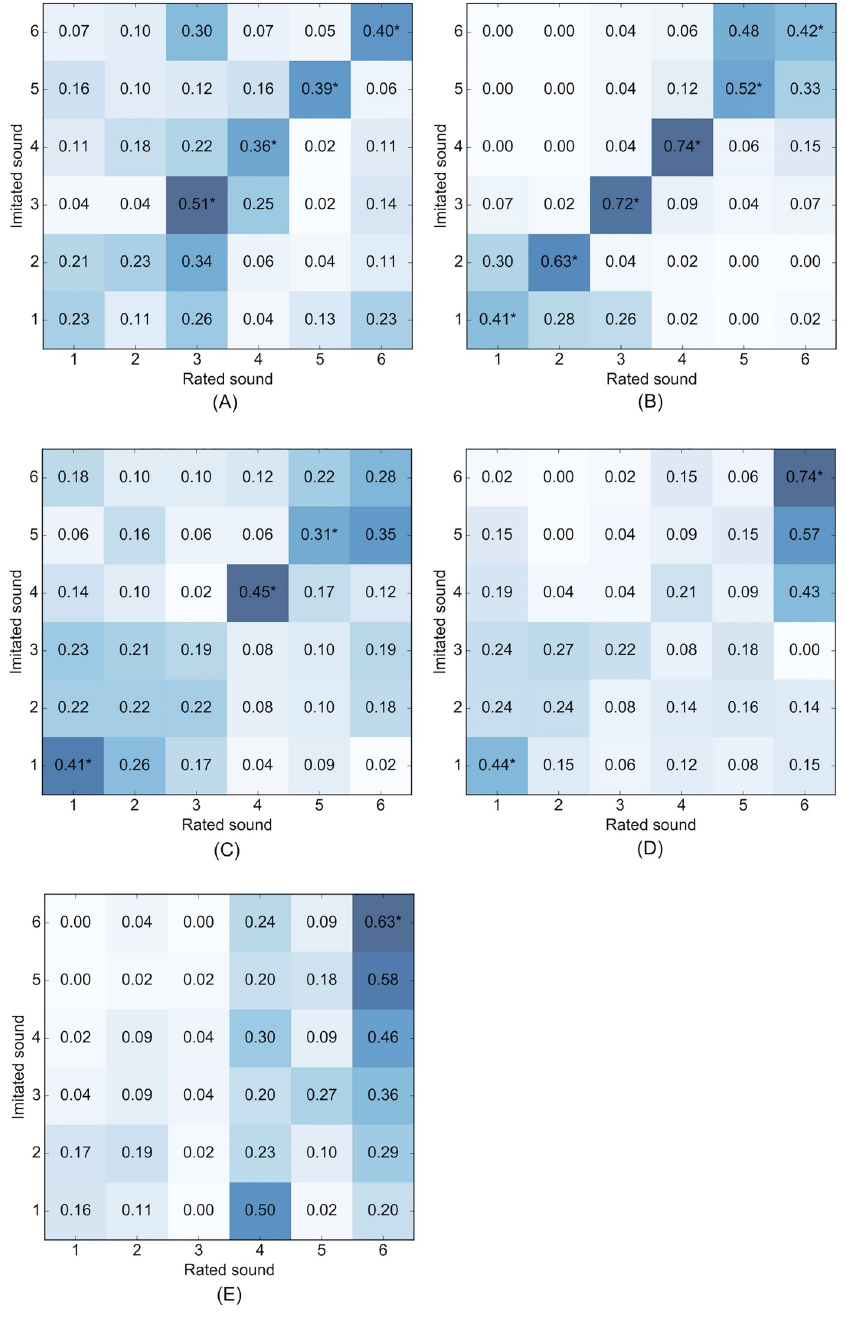
Fig 2. Contingency tables of the highest rated sound for each imitated (i.e. target) sound, by drum category. Cell values and shading indicate the proportion (0–1) of tests for a given imitated sound where the rated sound was considered most similar to the imitation. Asterisks in the diagonals indicate cases where the imitated sound was rated most similar to the imitation, significantly above chance ( p adj < 0.05). (A) Cymbals, (B) Hats, (C) Kicks, (D) Snares, (E)